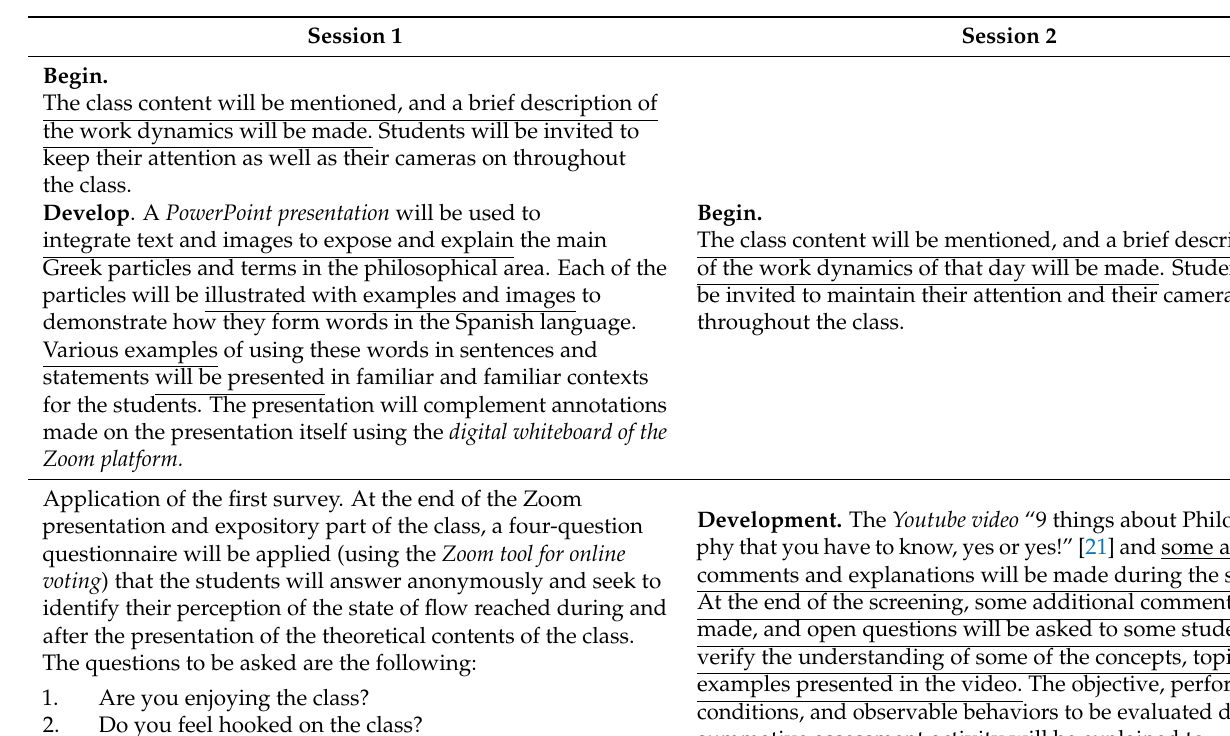
Table 2. Distribution of surveyed teachers according to the level or area in which they